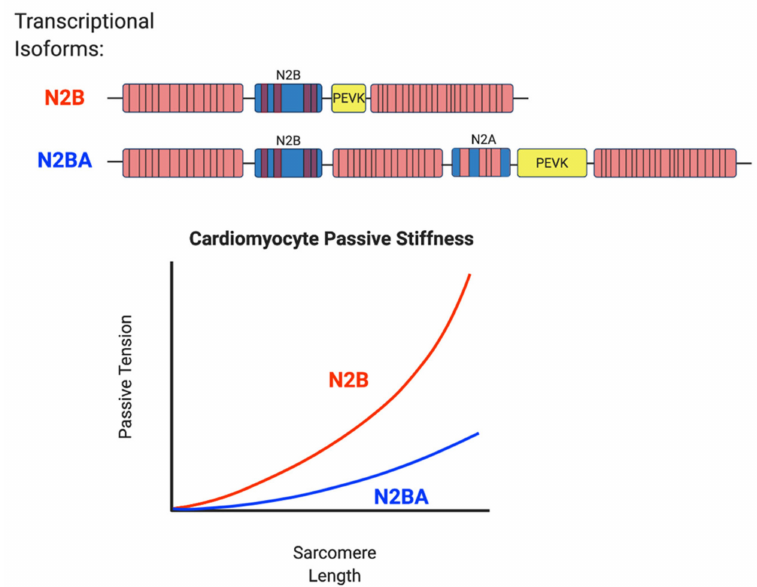
Figure 4. Transcriptional selection of titin isoforms a ff ects cardiomyocyte passive sti ff ness. There